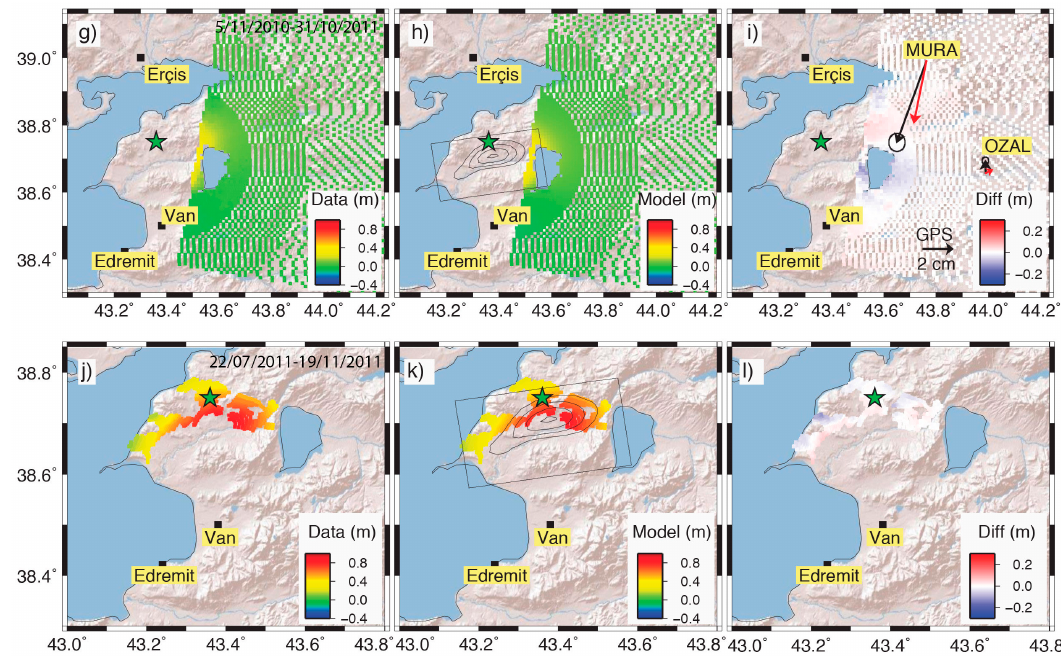
Figure 7. Comparisons between observed data (first column) and predictions (second column) related to the coseismic displacements of the Van earthquake. The residuals are observed minus modeled data (third column): ( a – c ) CSK1 (1210 data points); ( d – f ) CSK azimuth data (891 points); ( g – i ) ENV1 (2317 data points), near field GPS displacement vectors are also reported (black, observed; red, computed); and ( j – l ) ENV2 (896 data points). The green star is the hypocenter while the fault embedded in the FE model is indicated in black, with slip contour each 2 m.